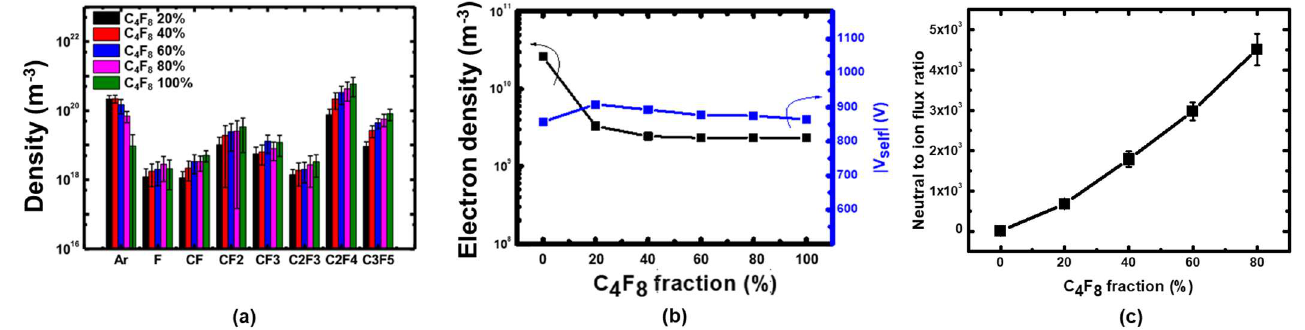
Figure 3. ( a ) Absolute neural species densities, (b) electron densities and self-bias voltages in the continuous wave discharges with various C 4 F 8 fractions, ( c ) calculated neutral to ion flux ratios based on the measurement data.